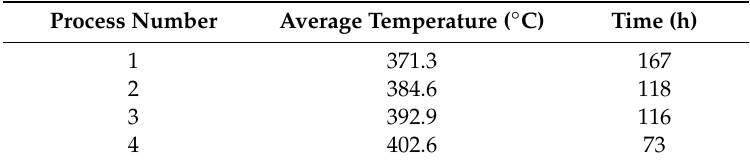
Table 1. Parameters of ion exchange processes for determination of temperature dependencies of di ff usion coe ffi cients.